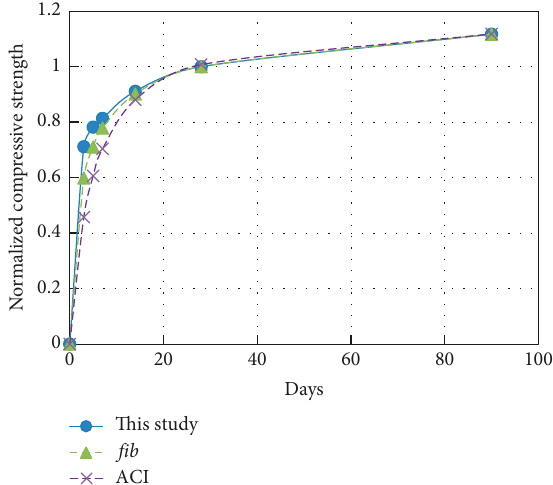
Figure 2: Normalized compressive strength of the fiber-reinforced alkali-activated slag-based composite with